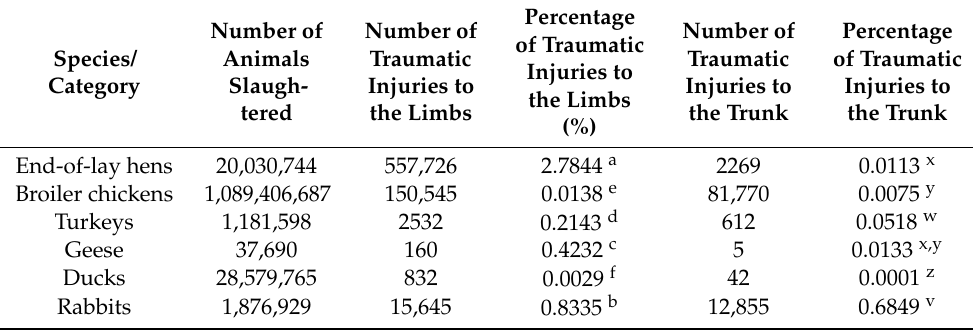
Table 1. The incidence of traumatic injuries to the limbs and trunk in poultry and rabbits as detected during slaughterhouse inspection in the Czech Republic from 2010 to 2019.